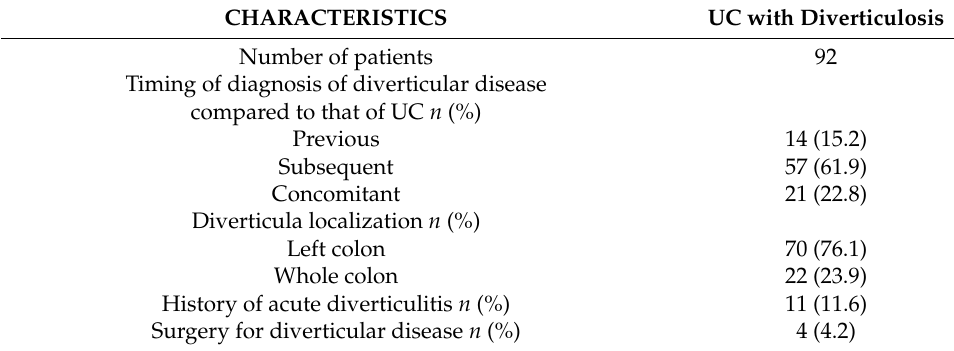
Table 1. Characteristics of diverticula in patients with ulcerative colitis (UC) and concomitant diverticular